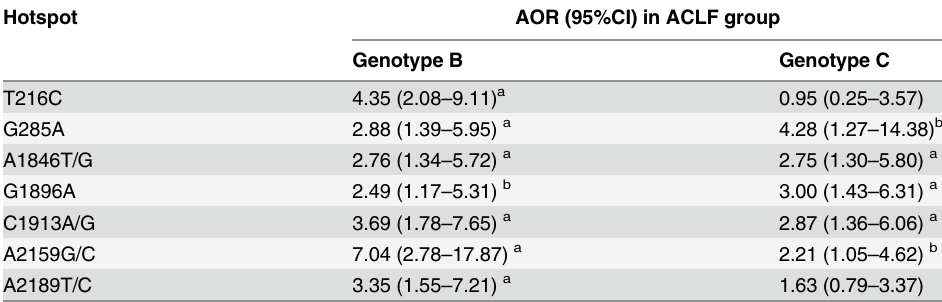
Table 5. The risks of ACLF cases with 7 site mutations on the basis of genotype B and genotype C as compared with non-ACLF